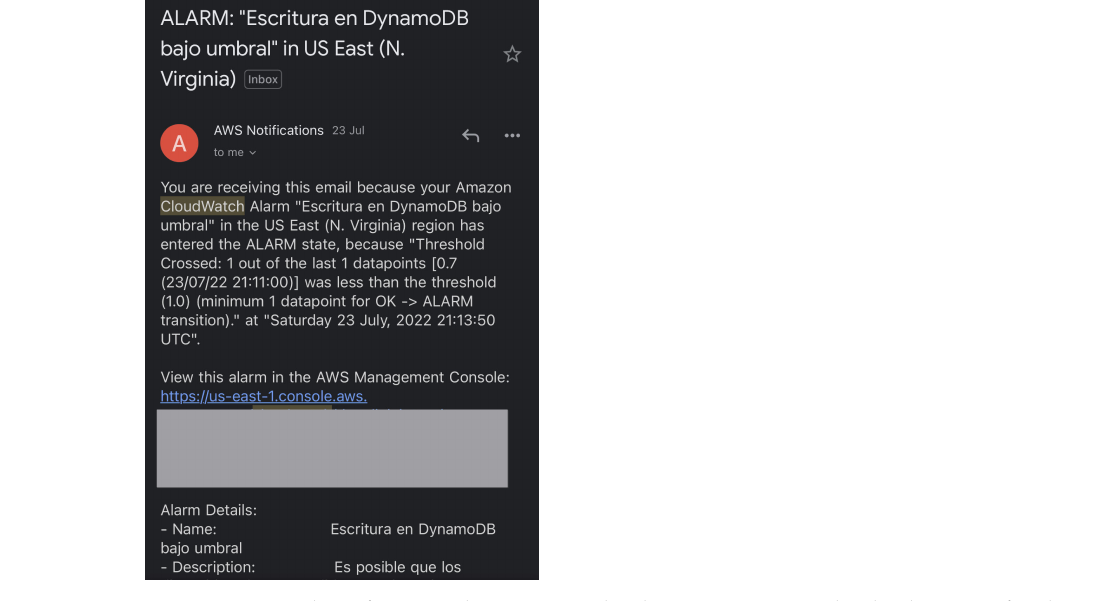
Figure A3. Email notification when a smart plug has not write into the database in a fixed period of